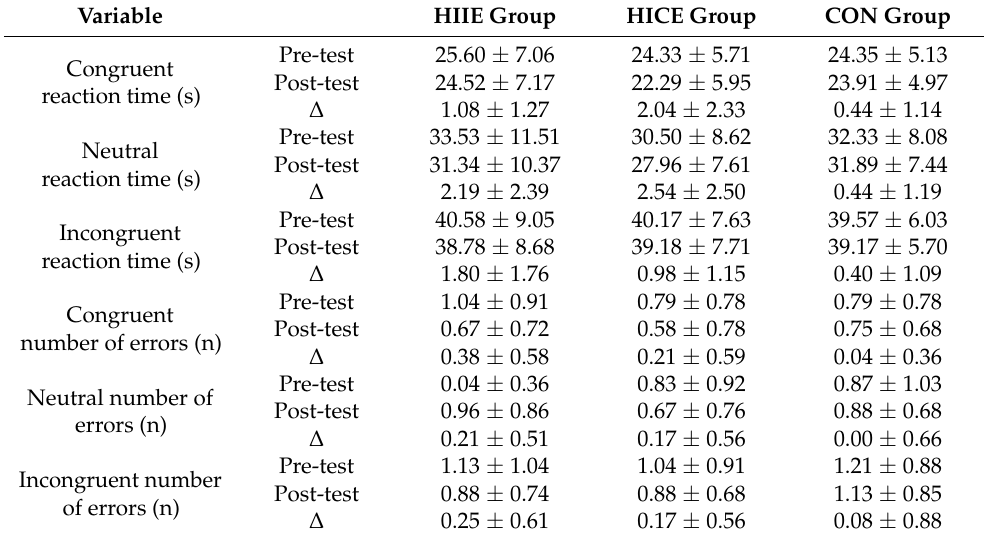
Table 2. Mean and SD (standard deviation) of the pre-test, post-test and ∆ of the ∆ Stroop behavior data recorded among the three groups. Note: HIIE = High-intensity interval exercise; HICE = High- intensity continuous exercise; CON = Control; ∆ = the difference between pre-test and